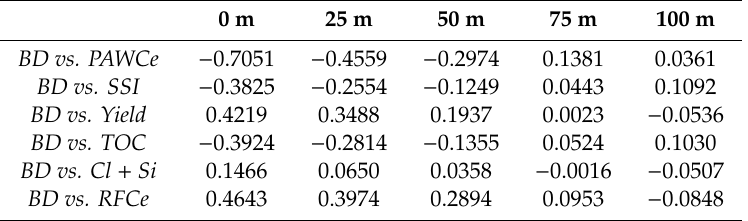
Table 6. Cross-correlation coe ffi cients computed at di ff erent lags between BD and other indicators maps. 0